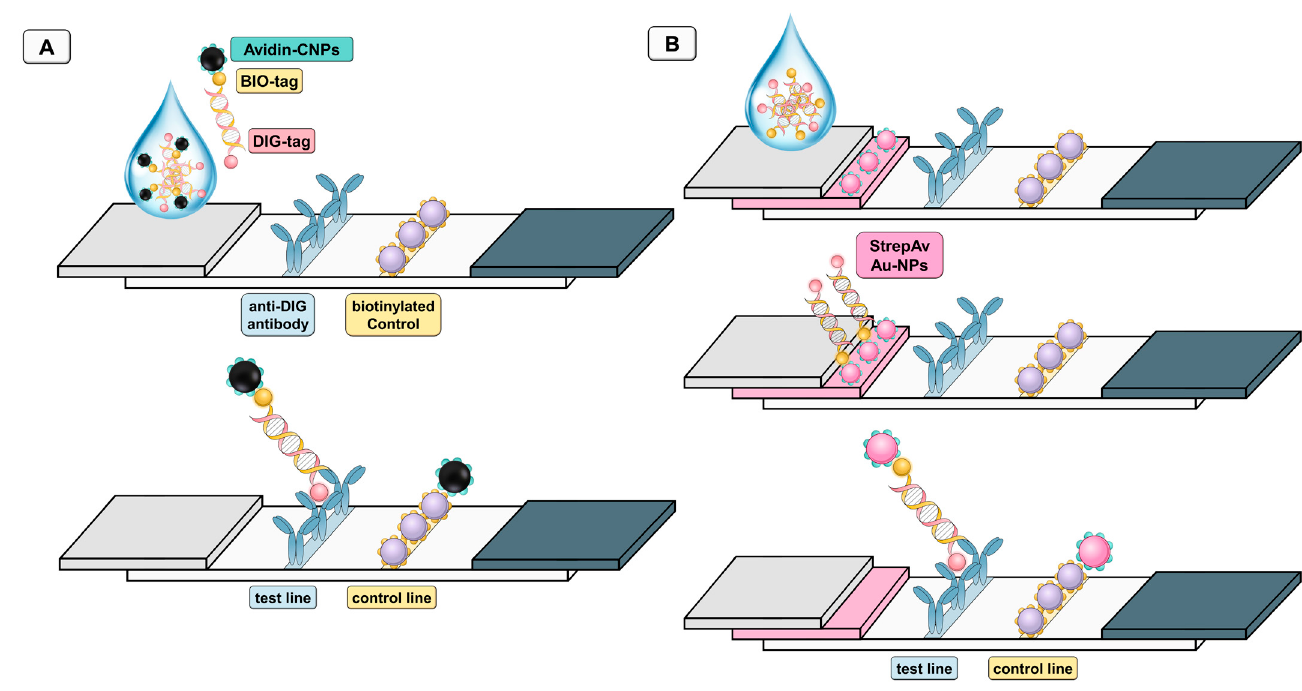
Figure 2. Schematic procedure of the lateral flow assay (LFA) based on avidin-modified carbon nanoparticles (Av-CNPs) ( A ) and based on commercial streptavidin gold nanoparticles, (streptAv-AuNPs) ( B ) for the detection of double-tagged amplicon labeled with biotin and digoxigenin. The test line is based in both instances on anti-digoxigenin antibody (anti-DIG antibody), while the control line is based on a biotinylated protein, so as to capture all the remaining Av-CNPs ( A ) or streptavidin ‐ modified AuNPs ( B ).